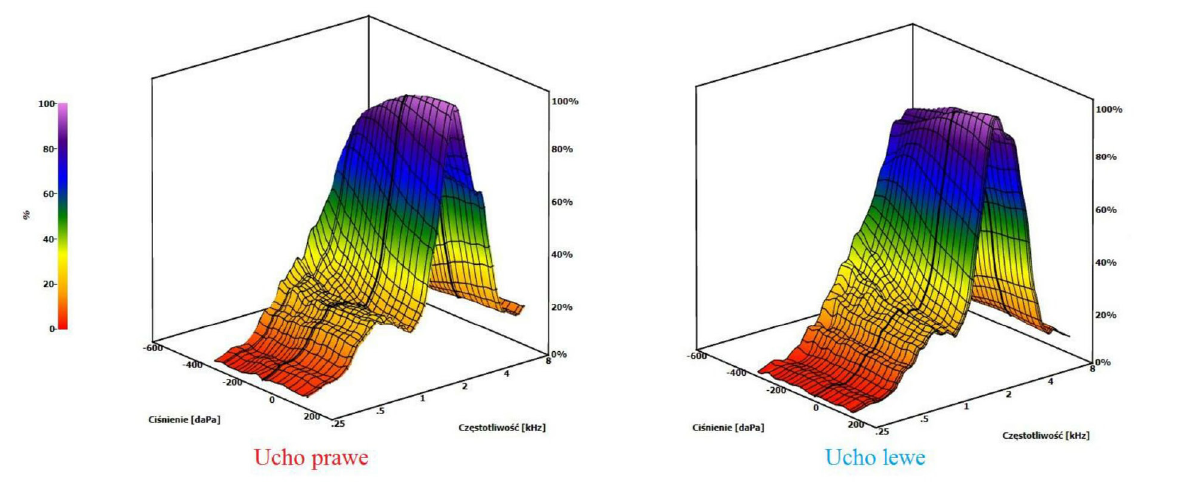
Figure 7. Results of wideband tympanometry, right and left ear.